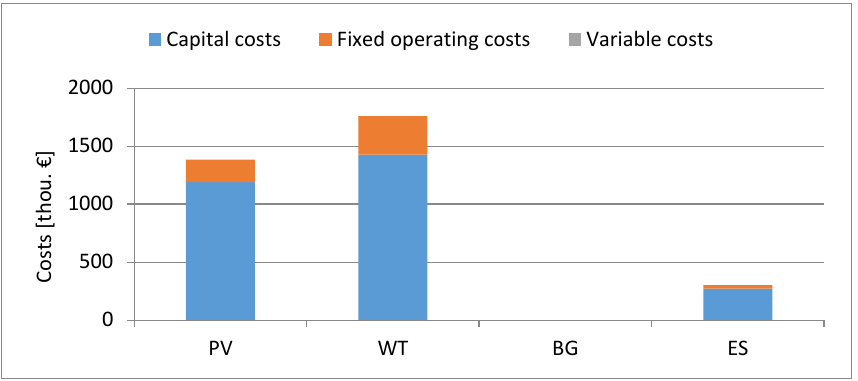
Figure 3. The cost structure for scenario “2”.